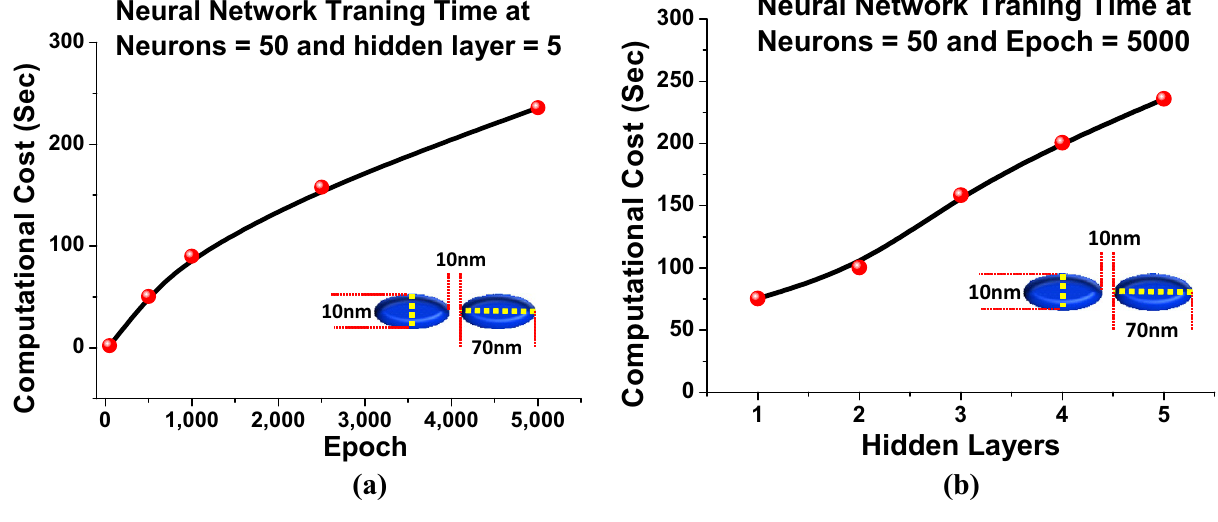
Figure 6. ( a ) Shows the computational Cost (Sec) for the DNN training with respect to different epoch ( b ) Represents the comparison in computational cost for different hidden layers .